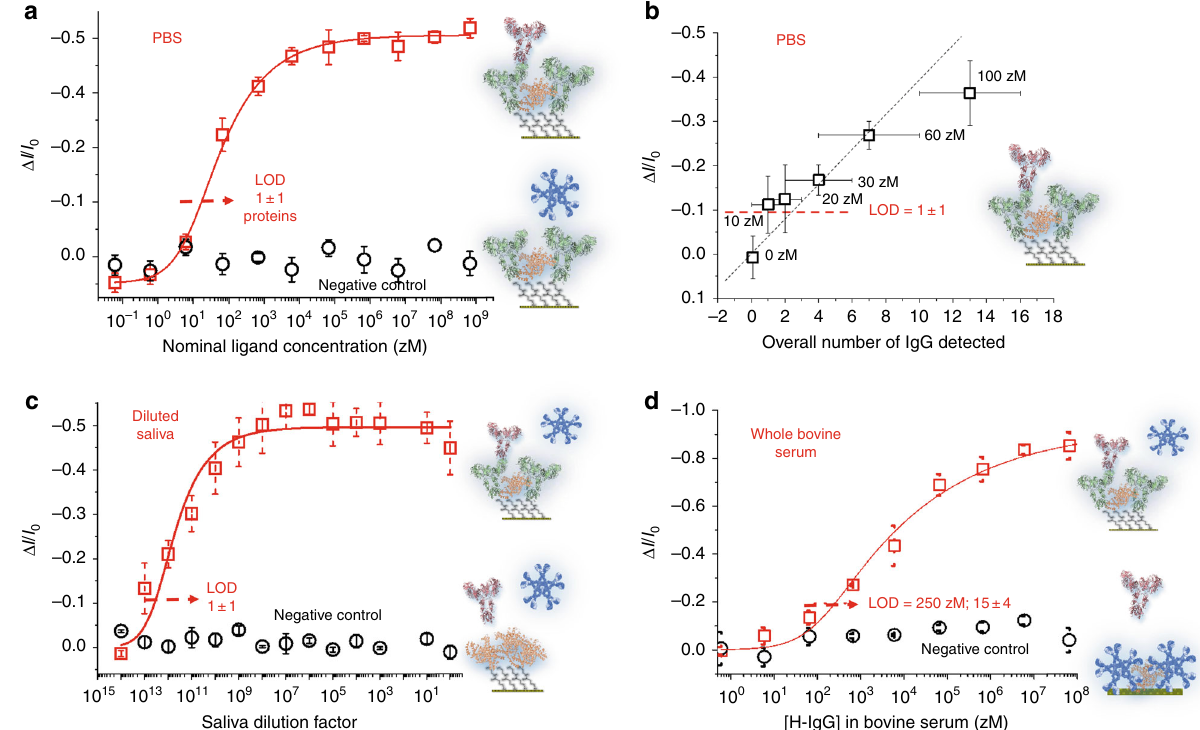
Fig. 3 Protein detection at the physical limit in different bio- fl uids. a The Human IgG/anti-Human-IgG af fi nity binding calibration curve (red squares) as the relative change of the I D current ( Δ I / I o ) vs. the IgG concentration. A SAM comprising both the capturing anti-IgG and the BSA is used. The black circles are the negative control responses of the anti-IgG SAM to human-IgM solutions. The proteins are assays from standard solutions in PBS. The fi tting of the IgG binding curve with the SiMoT dose curve model described in Supplementary Note 7, is shown as red solid line. b The IgG assay in PBS carried out in the 0 – 100 zM range. As a single gate is used to detect molecule numbers ranging within one order of magnitude, the responses are plotted against the total number of ligands present in all the solutions sampled until the incubation at that concentration is reached, along with the relevant Poisson errors. The data provided are averages over 5 replicates and error bars are taken as one standard deviation. c The SiMoT is engaged in the detection of IgG in a diluted sample of real human saliva. The IgG concentration of the whole saliva, independently assayed by means of surface plasmon resonance (Supplementary Note 9), is C sal = 40 ± 6 nM (10 − 9 M). The data points are relevant to three replicates for each dose curve while the saliva was sampled from the